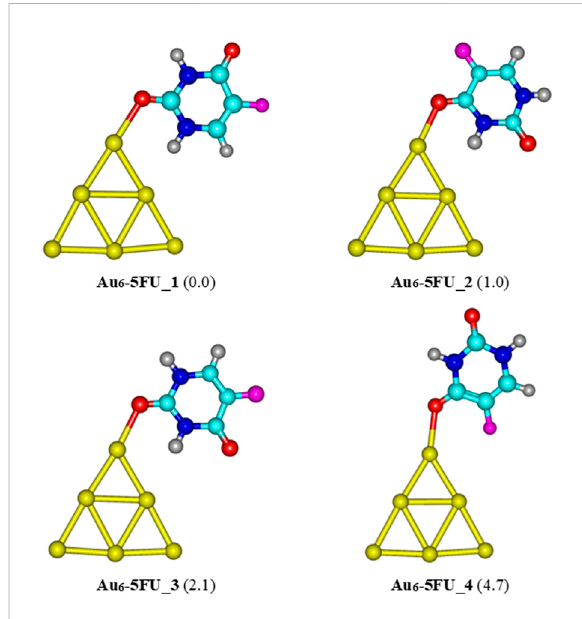
FIGURE 4 Low-lying structures of the Au 6 -5FU complex in gas-phase. Values given in parentheses are relative energies (kcal/mol) with respect to the most stable form Au 6 -5FU_1. Yellow, cyan, blue, white-gray,red,andmagentaareusedtorepresenttheAu,C, N, H, O, and F atoms, respectively.